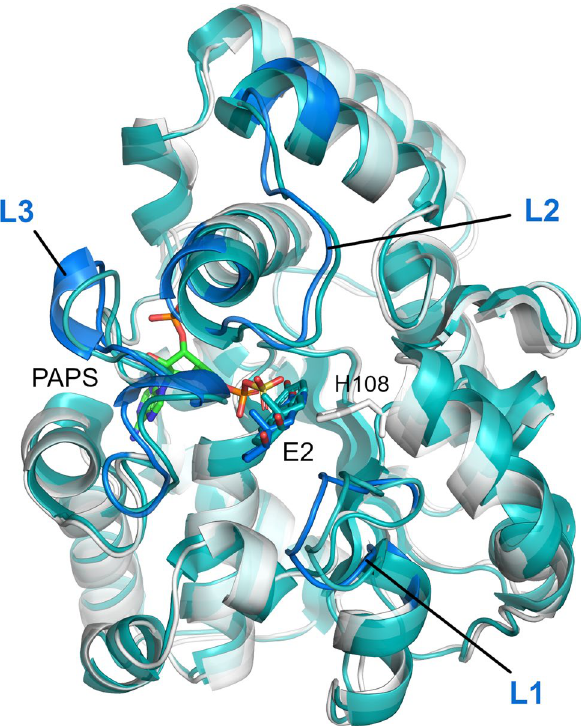
Figure 7. A favorable docking position of E2 in an MDeNM generated conformation (in white) superposed to the crystal structure of SULT1A1*2 co-crystalized with E2 (2D06.pdb –in cyan).